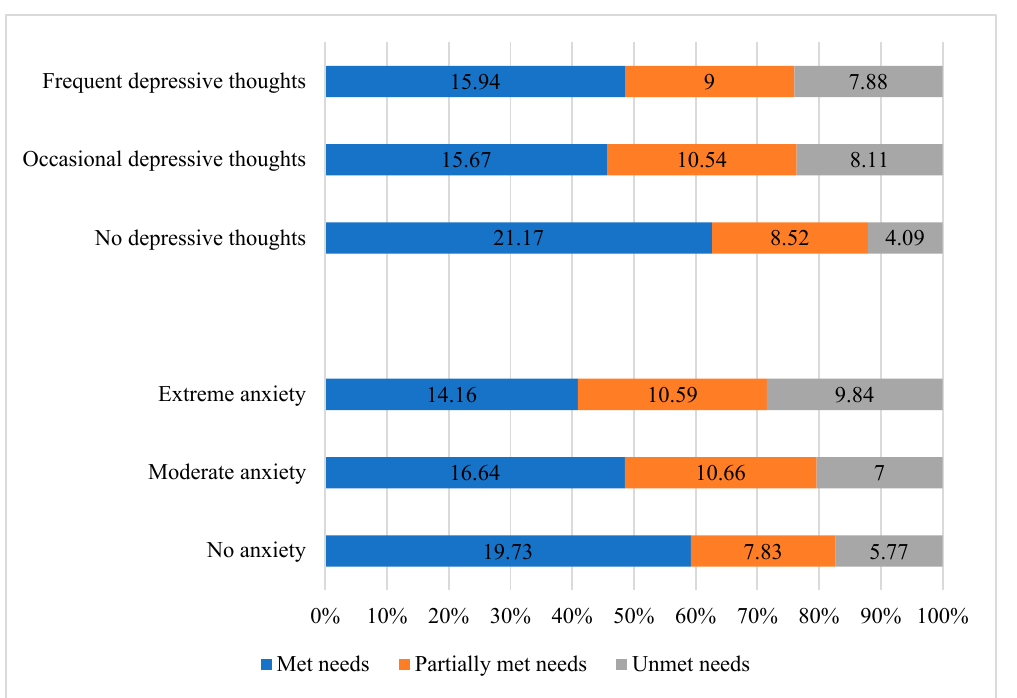
Figure 5. Number of met, partially met, and unmet needs according to the anxious and depressive symptoms.